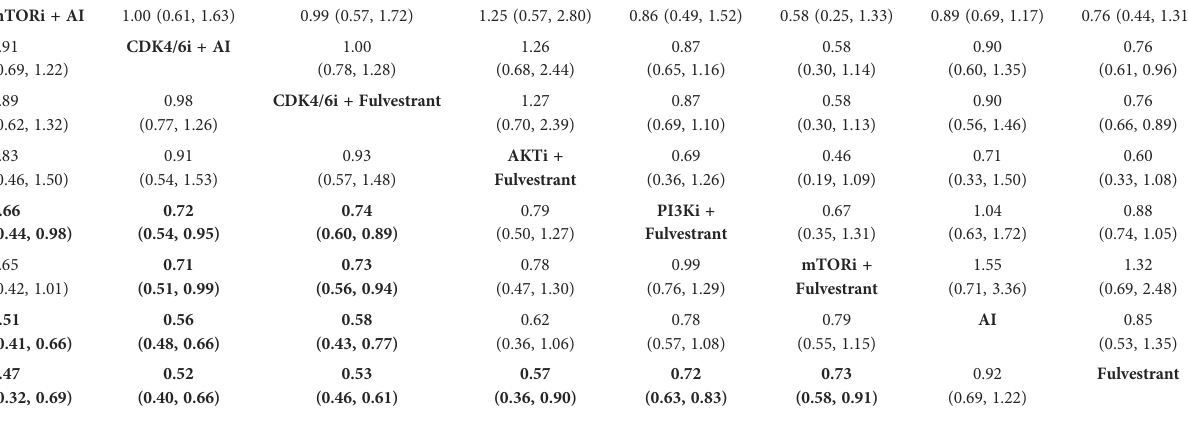
TABLE 3 Pairwise comparisons of 8 interventions for PFS and OS (HR, 95% CrI).